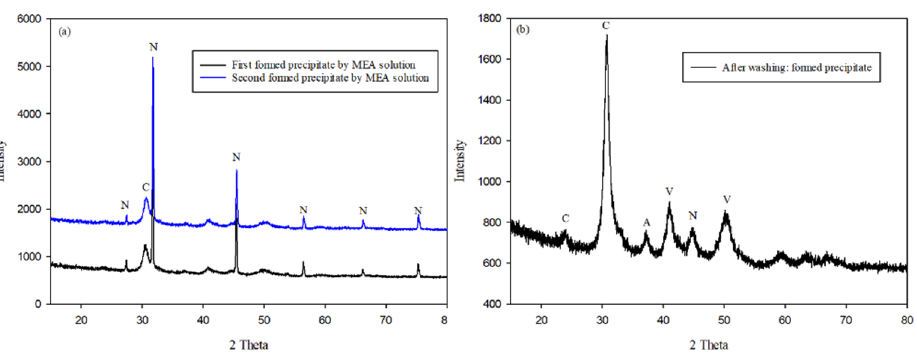
Figure 3. XRD results for precipitate formed in 5 wt % MEA solution with simulated seawater: ( a ) unwashed precipitate and ( b ) washed precipitate. (N: NaCl, C: calcite, V: vaterite, A: aragonite).